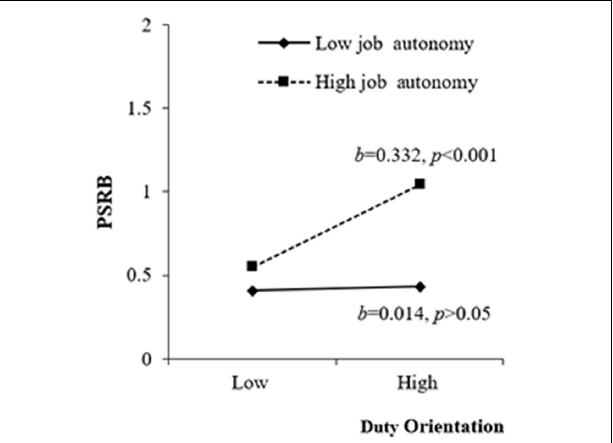
FIGURE 4 | Moderating effect of leader reward omission between achievement orientation and